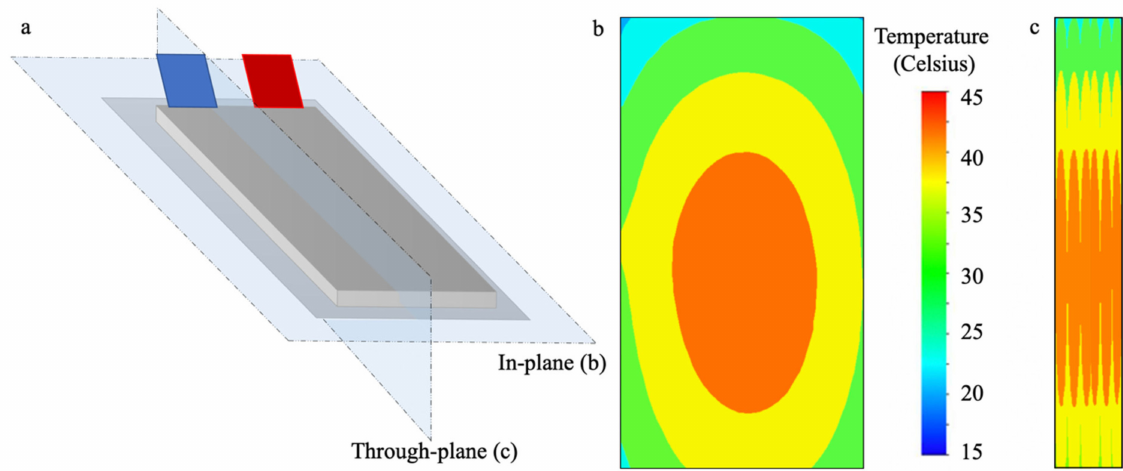
Figure 3. Schematic of temperature within a pouch cell. A LiB pouch cell ( a ) dimensions for the in-plane and through-plane geometries, temperature distribution of a LiB in-plane ( b ) and temperature distribution through-plane ( c